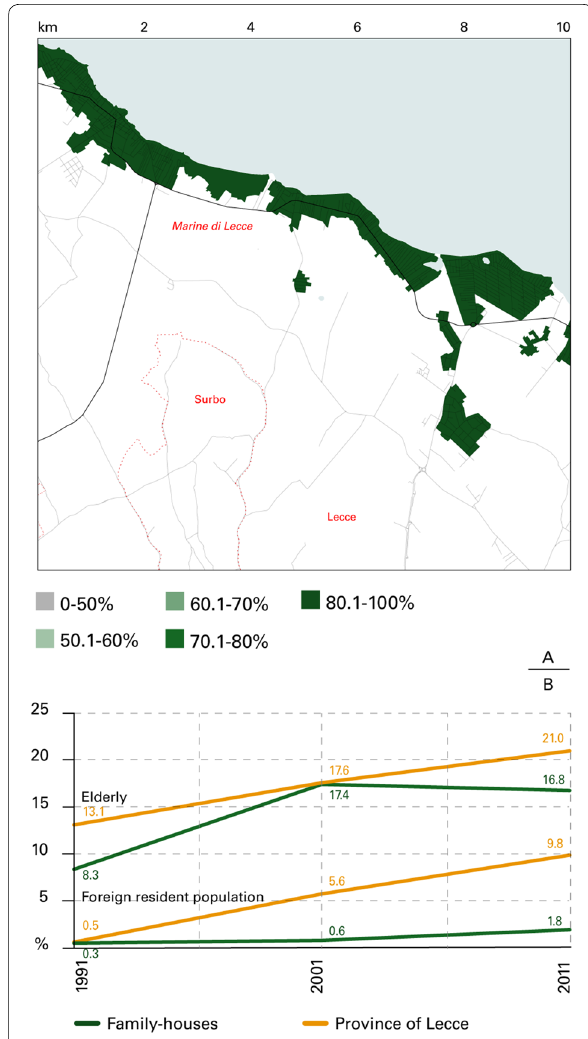
Fig. 12 a Municipality of Lecce, 10 10 km sample. Percentage of × one- and two-interior buildings built in the period 1961–1991 out of the total residential stock at 2011 (authors’ calculations on data from Istat census). b Municipality of Lecce: trends in the elderly and foreign population within the census blocks where family houses constitute more than 50% of the housing stock (authors’ calculations on data from Istat